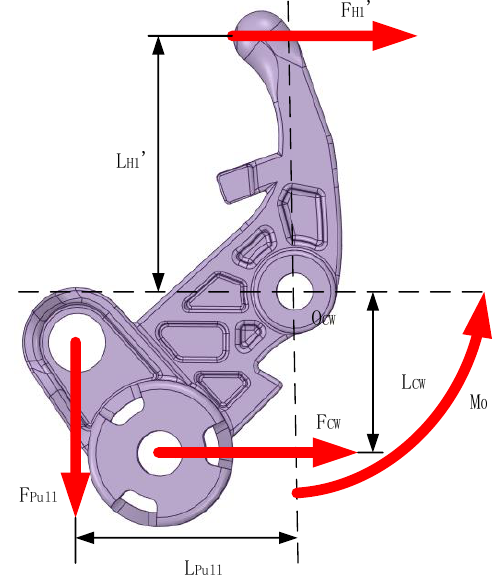
Figure 9. Schematic diagram of counterweight mechanism.